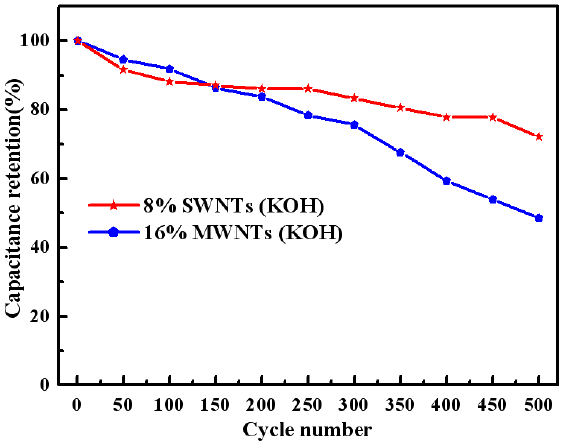
Figure 11. Variation of specific capacitance with cycle number for the composites in 6 M KOH at a current density of 3 mAcm −2